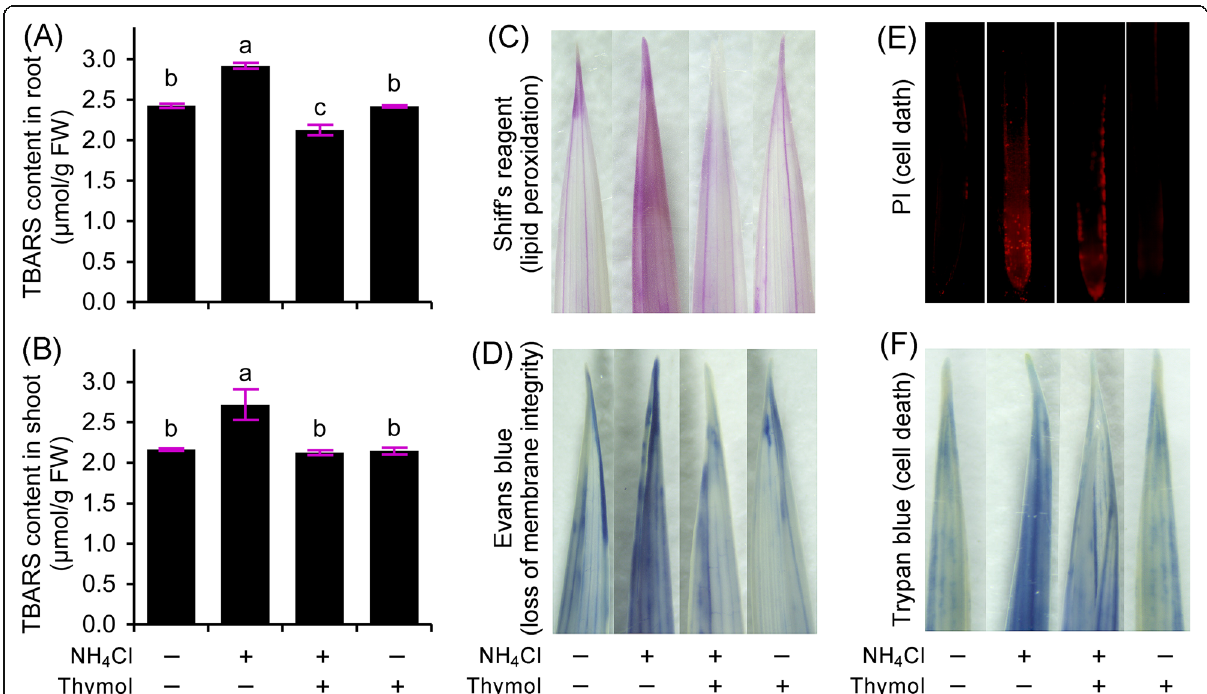
Fig. 2 Thymol attenuated ammonium-induced oxidative injury in rice seedlings. (A-B) Changes in TBARS content in root and shoot after NH 4 Cl exposure for 72 h. (C-F) Detection lipid peroxidation in leaf (C), loss of membrane integrity in leaf (D), and cell death in root (E), and cell death in